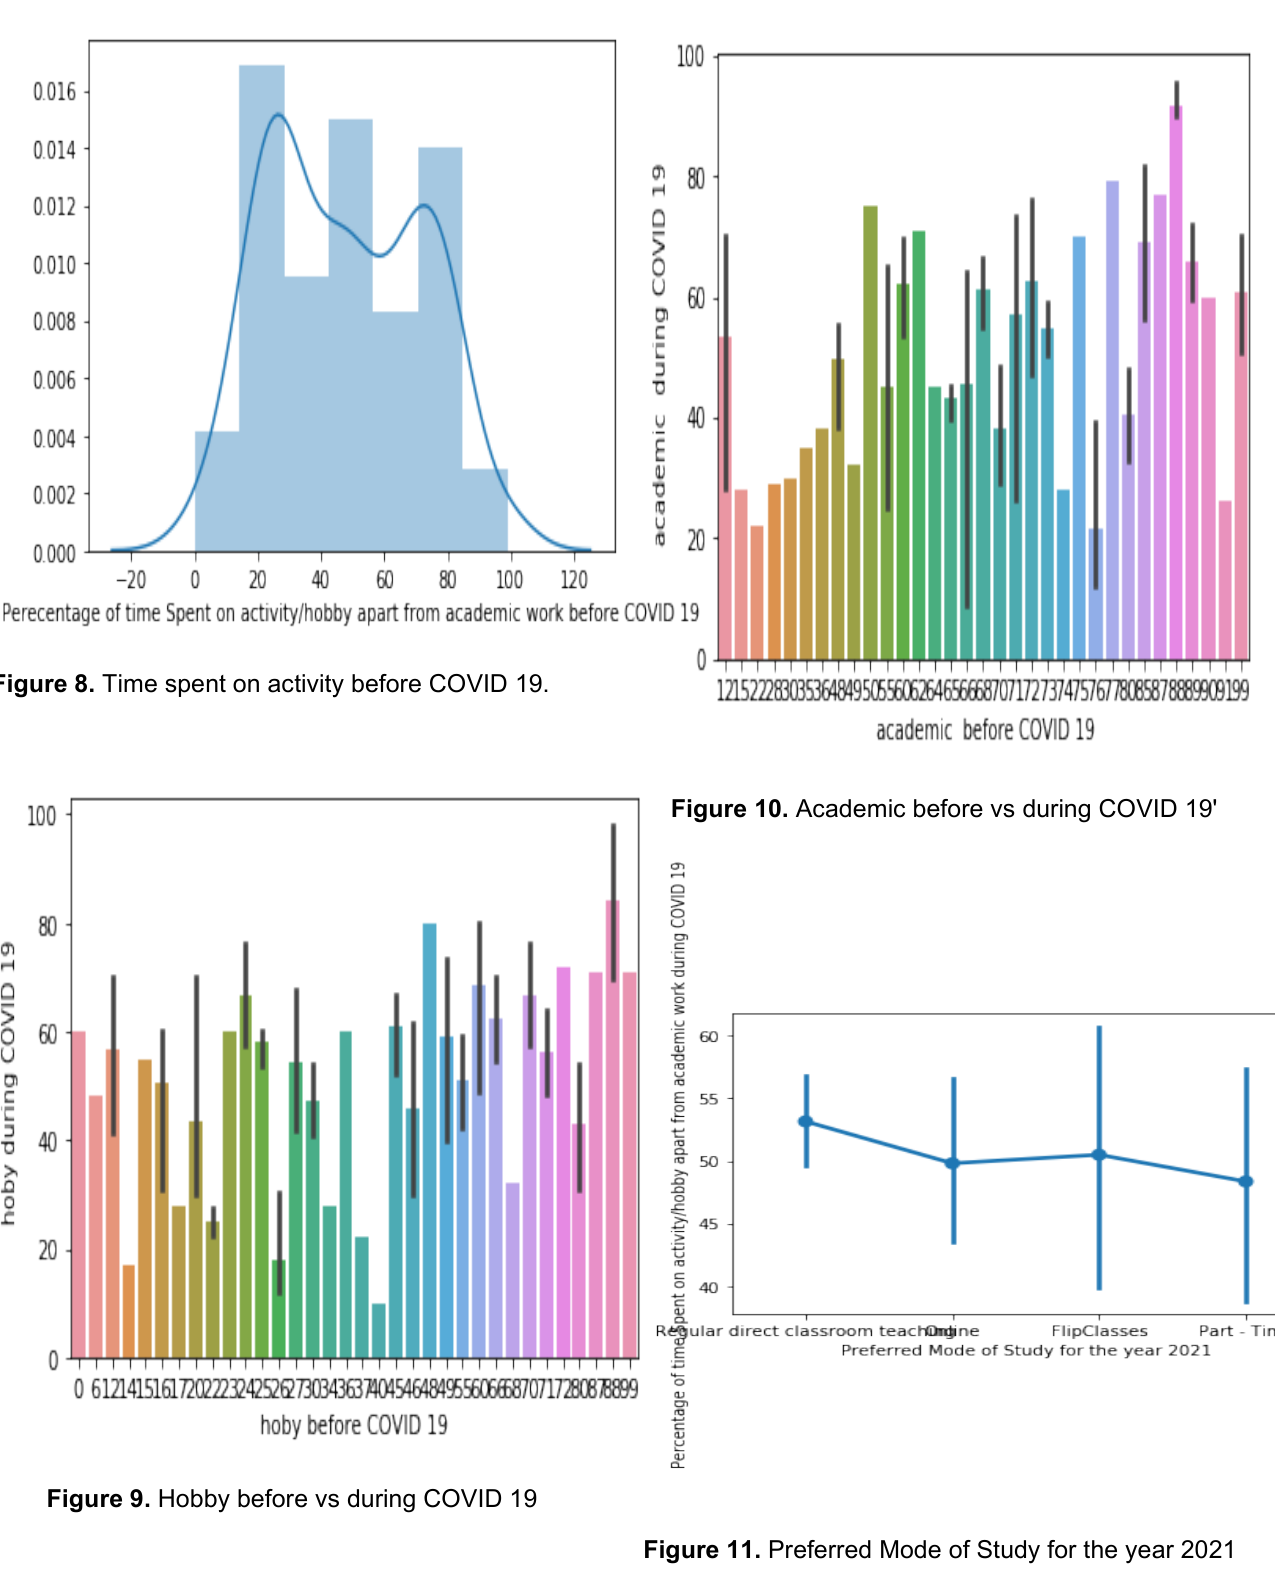
Figure 11. Preferred Mode of Study for the year